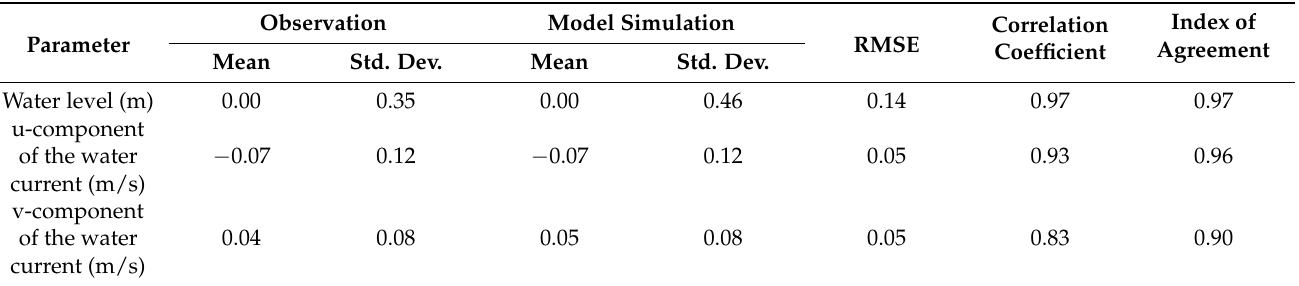
Table 2. Statistical assessment of the hydrodynamic model performance at S2 for the water level, and u and v components of the water